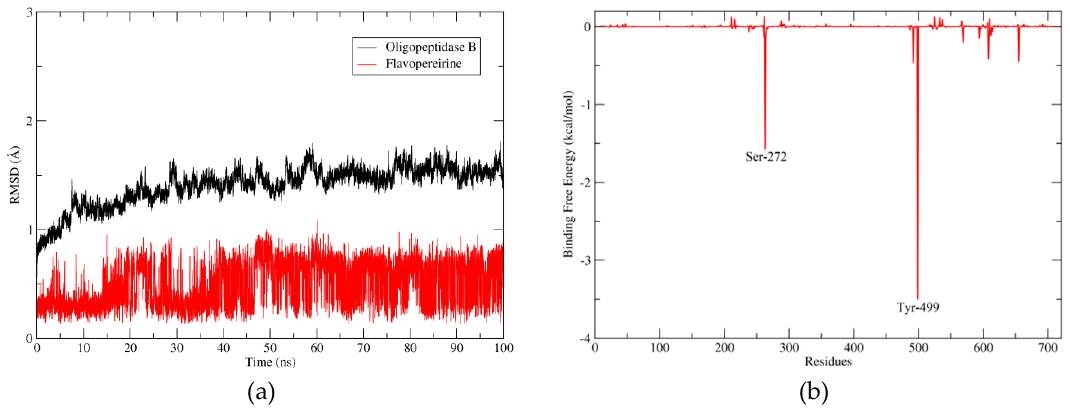
Figure 5. Molecular dynamics results. ( a ) RMSD x Time graphic of the molecular dynamics, with the black line representing the fluctuation of OpB and the red line the fluctuation of flavopereirine. ( b ) The main contributions to the binding free energy of each residue from OpB, mainly Ser-272 and Tyr- 499.